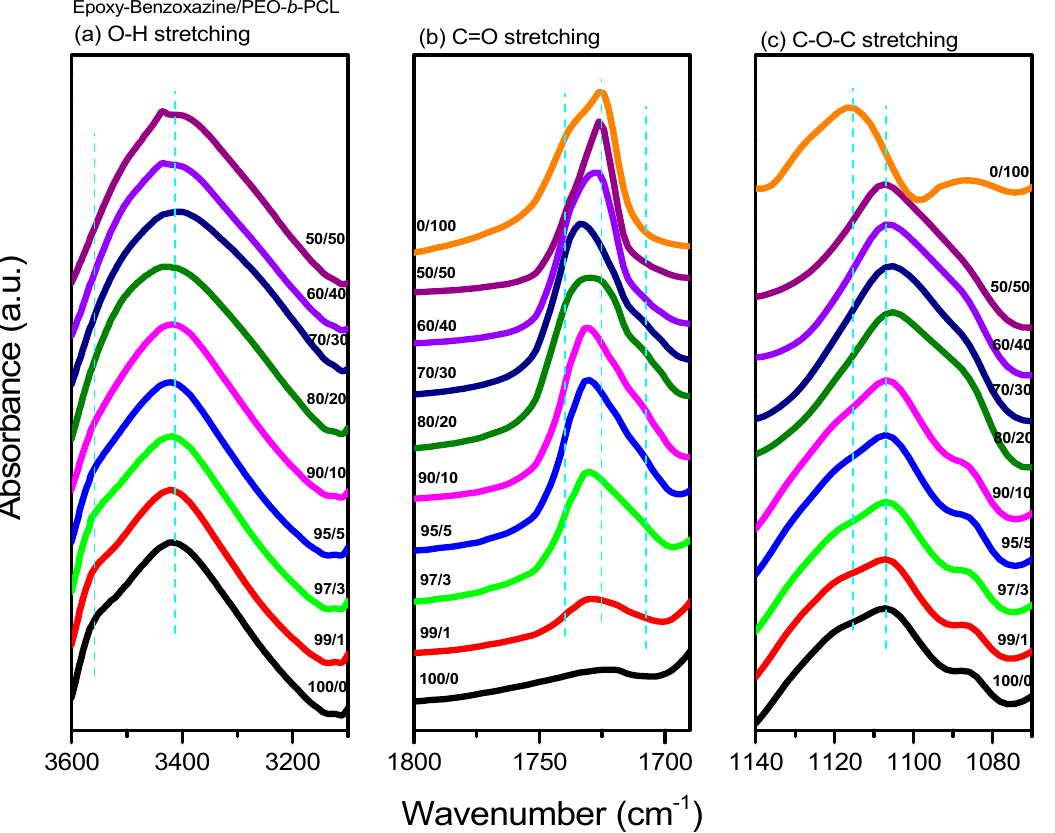
Figure 8. Fourier transform infrared (FTIR) spectra (recorded at room temperature) of epoxy– benzoxazine/PEO- b -PCL blends, displaying the ( a ) OH, ( b ) C=O, and ( c ) C–O–C stretching regions.